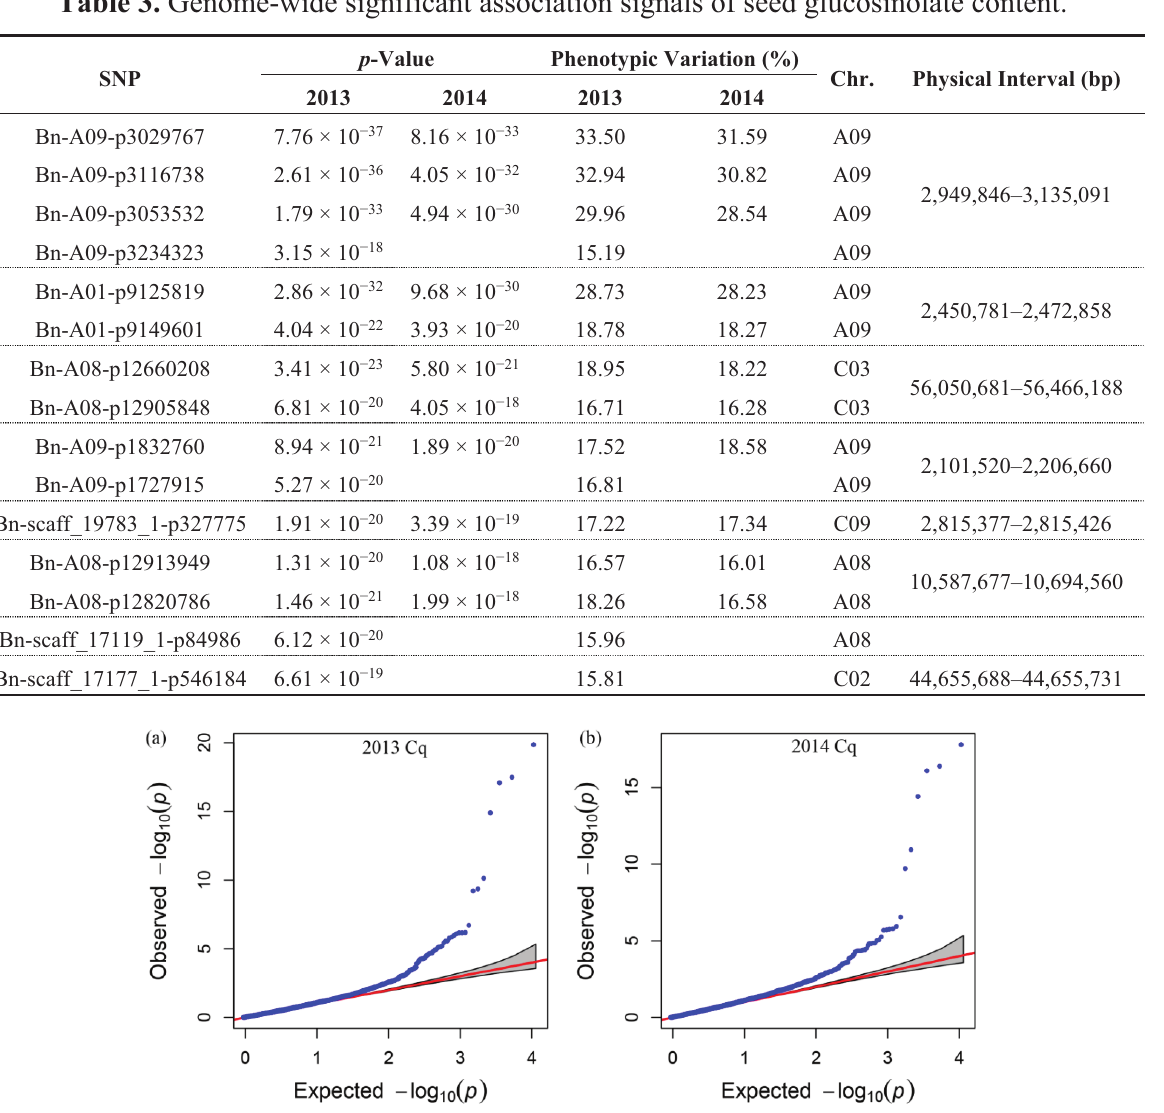
Figure 4. Quantile–quantile plots of evaluated (cid:3) log10(P) from association analysis of seed glucosinolate content using the Q + K model. ( a ) Quantile–quantile plots of evaluated (cid:3) log10(P) from association analysis of seed glucosinolate content in 2013; ( b ) Quantile–quantile plots of evaluated (cid:3) log10(P) from association analysis of seed glucosinolate content in 2014. Cq refers to the growing region, Chongqing,